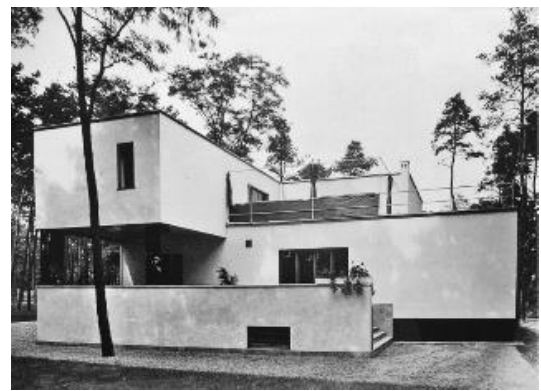
Figure 3. photograph, taken by Ise Gropius in 1926, became one of the most iconic images of the House Gropius after the building’s destruction in 1945. (Pevsner, 1968).